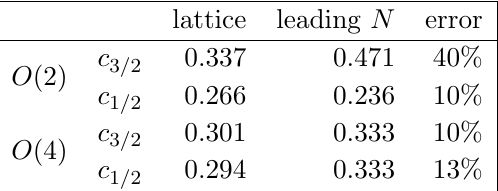
Table 1 . Lattice results for the coe(cid:14)cients c 3 = 2 and c 1 = 2 in the large-charge expansion of the conformal dimension (cid:1)( Q ) = c 3 = 2 Q 3 = 2 + c 1 = 2 Q 1 = 2 + : : : in the O (2) and O (4) models [23, 24], compared with the large- N result in eq.